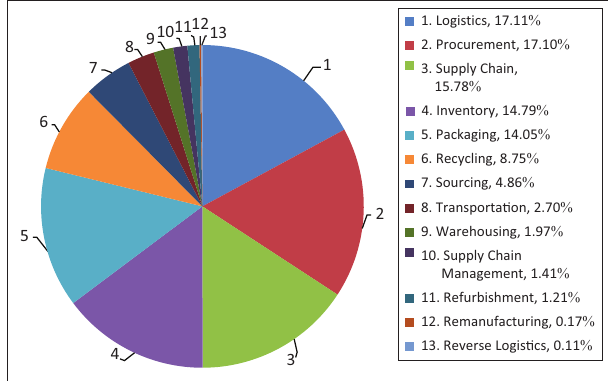
FIGURE 1: Relative frequency of supply chain